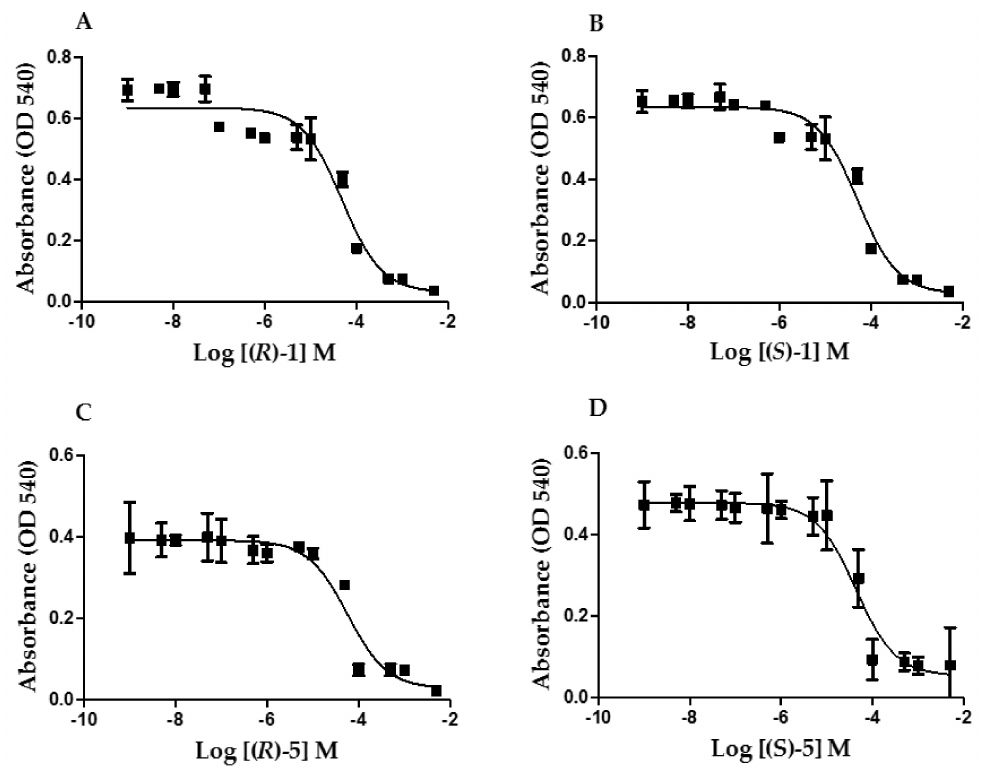
Figure 3. Dose response curves of HT29 cell viability upon treatment with di ff erent concentrations of